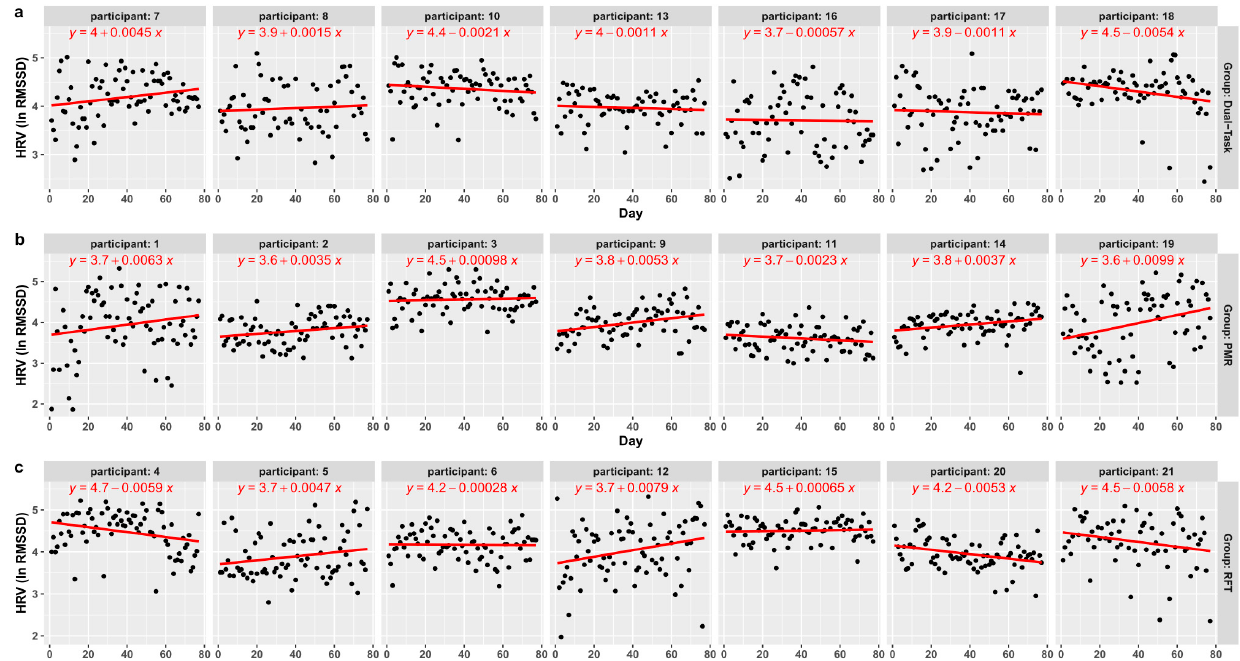
Figure 2. ( a – c ) Daily HRV measurement of each participant; the graph also includes the individual linear equation (random effects) of each participant. Table 2. Linear Mixed Effect Model, using Resting HRV (ln RMSSD) as the Criterion.